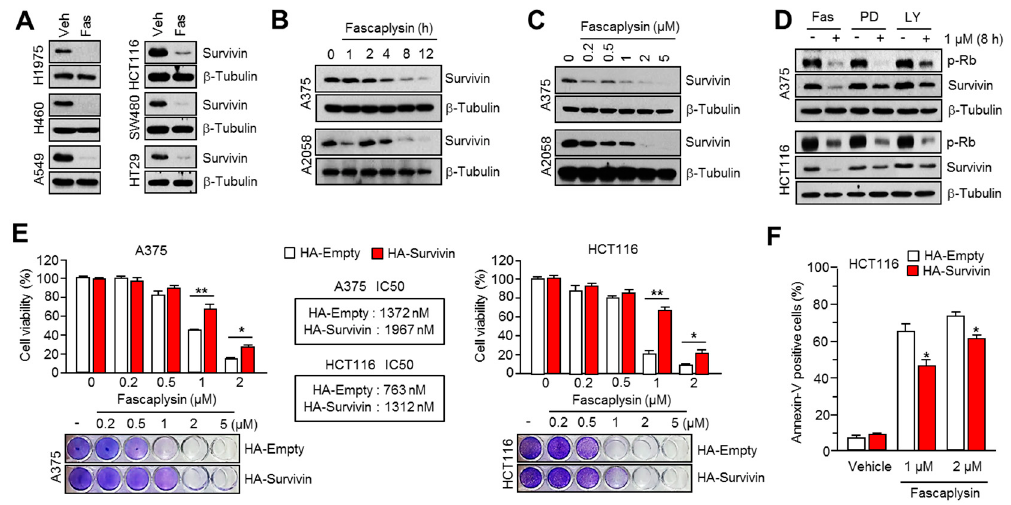
Figure 2. Fascaplysin induced apoptosis by suppressing survivin expression. ( A ) Multiple types of cancer cells were incubated with 1 µ M of fascaplysin for 12 h, and then the survivin protein was measured by western blotting; ( B , C ) A375 and A2058 cells were treated with fascaplysin in a time- or dose-dependent manner as indicated. The levels of survivin were measured by Western blotting; ( D ) A375 and HCT116 cells were incubated with 1 µ M of CDK4 inhibitors for 8 h; ( E ) The cell viability was measured in A375 or HCT116 cells that were overexpressing an empty vector or HA-tagged survivin upon fascaplysin treatment as indicated. Crystal violet staining images are shown. Values represent the mean ± SD of three independent experiments performed in triplicate; * p < 0.05 and ** p < 0.01; ( F ) HCT116 cells overexpressing an empty vector or HA-tagged survivin were incubated for 48 h in the absence or presence of 1 or 2 µ M of fascaplysin. After annexin-V staining, the population of cells was determined by FACS analysis. Values represent mean ± SD of three independent experiments performed in triplicate; * p < 0.05.